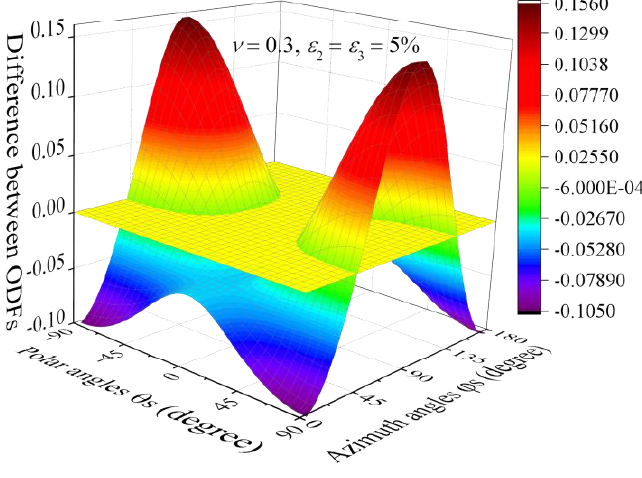
Figure 4. Difference between two ODFs.